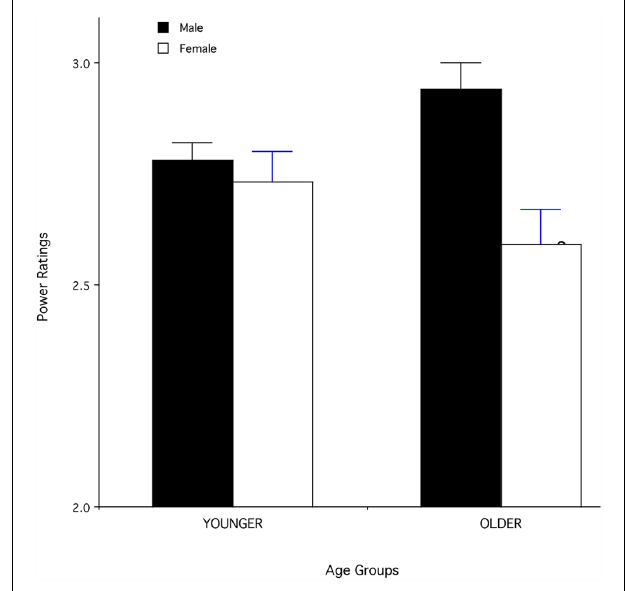
FIGURE 2 | Mean ( + SEM) ratings of power for male and female face stimuli in the younger (35–50 years) and older (51–65 years) age groups. Data for female respondents